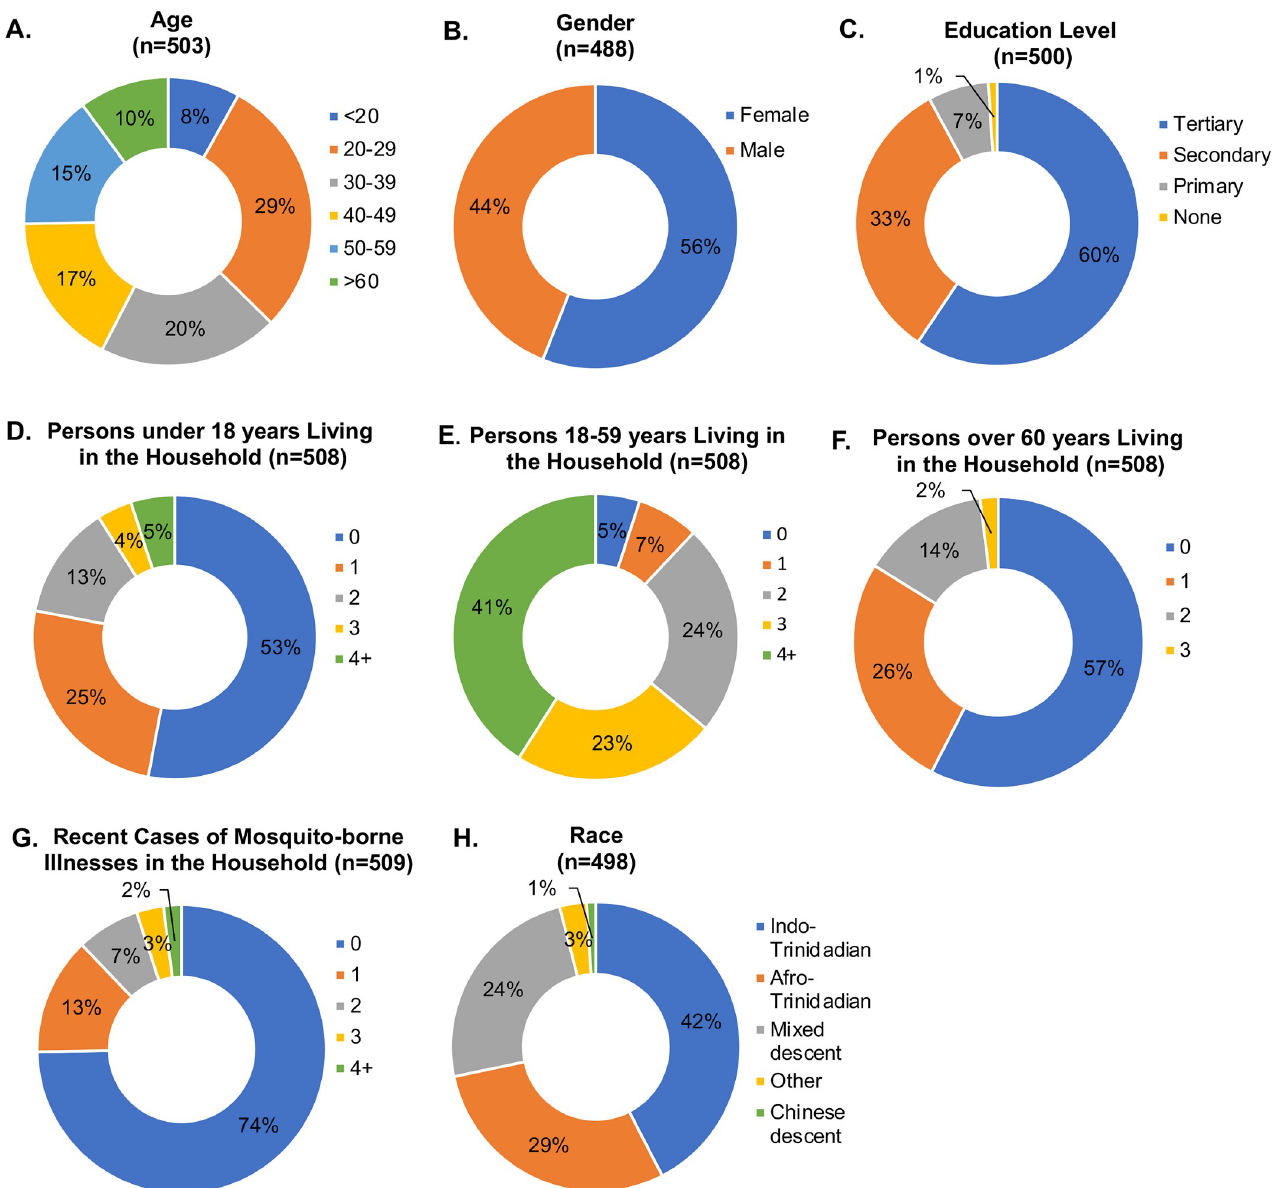
Fig 2. Demographic information for survey respondents. Data on participants’ age, gender, race, highest level of education attained or enrolled, the age of persons in the participant’s household, recent cases of mosquito-borne illness in the household, and race are summarized.